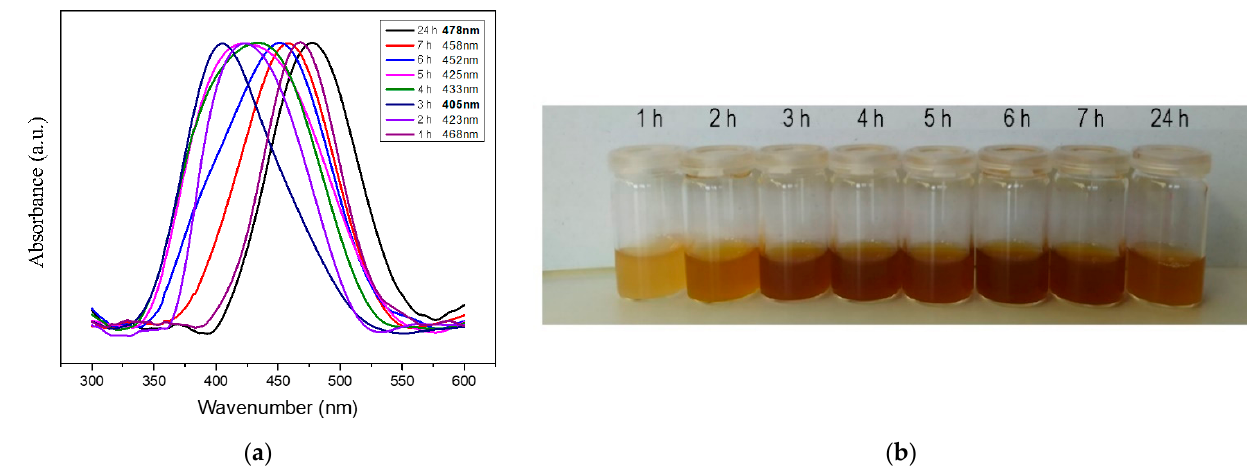
Figure 5. ( a ) UV absorption spectra of the PMAA@Ag aliquots sampled at different time periods; ( b ) vials containing the PMAA@Ag aliquots after reduction with NaBH 4 . Table 1. Absorption band maxima, FWHM, and area versus time of stirring in AgNO 3 . Time of Stirring in AgNO 3 (h)